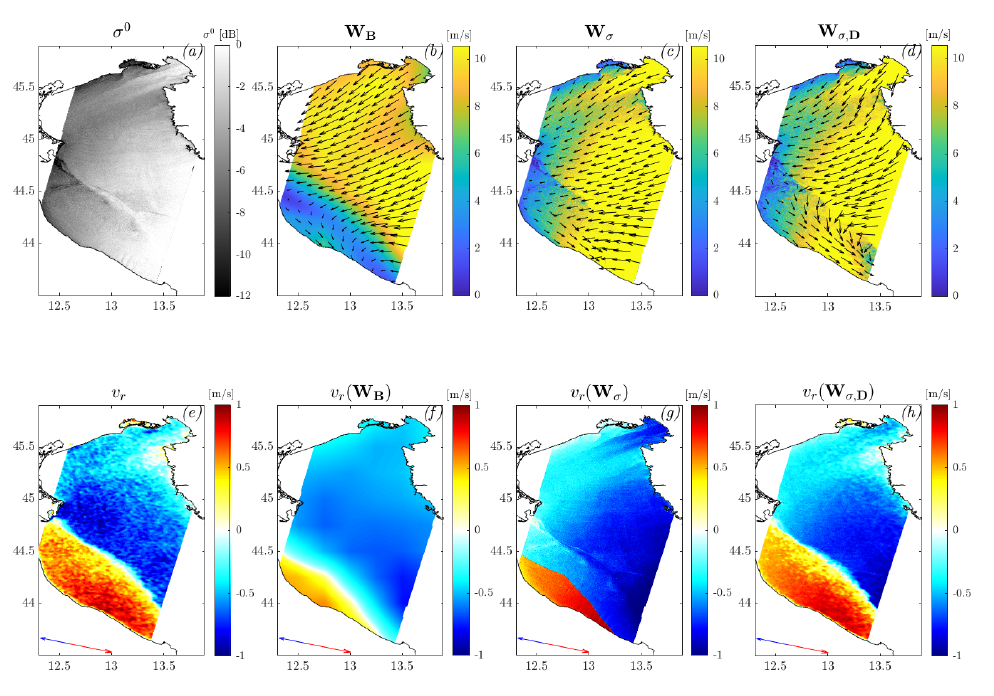
Figure 9. Results related to the descending acquisition of 12 December 2008. The panel composition follows the one in Figure